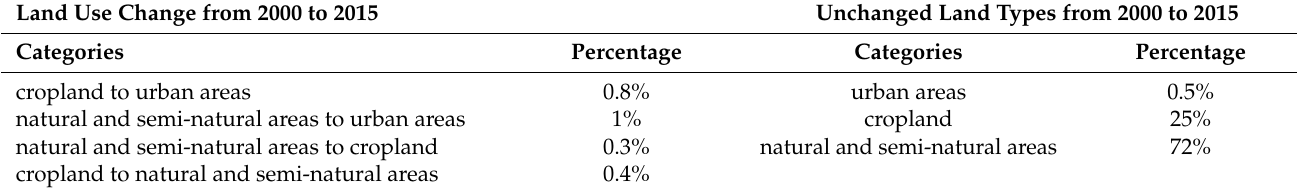
Figure 2. Flow chart of land type classification. Table 2. Statistics on the proportion of land type change.